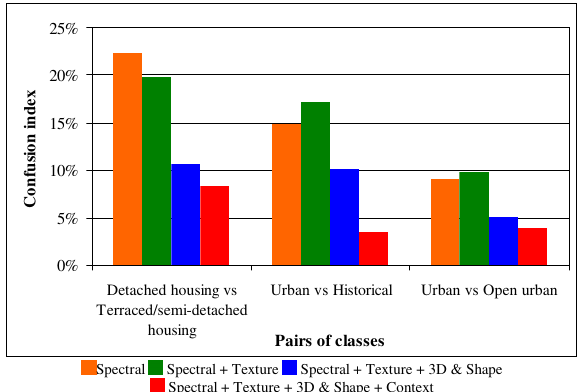
Figure 5. Evolution of confusion index when descriptive features are successively introduced into the classification model.